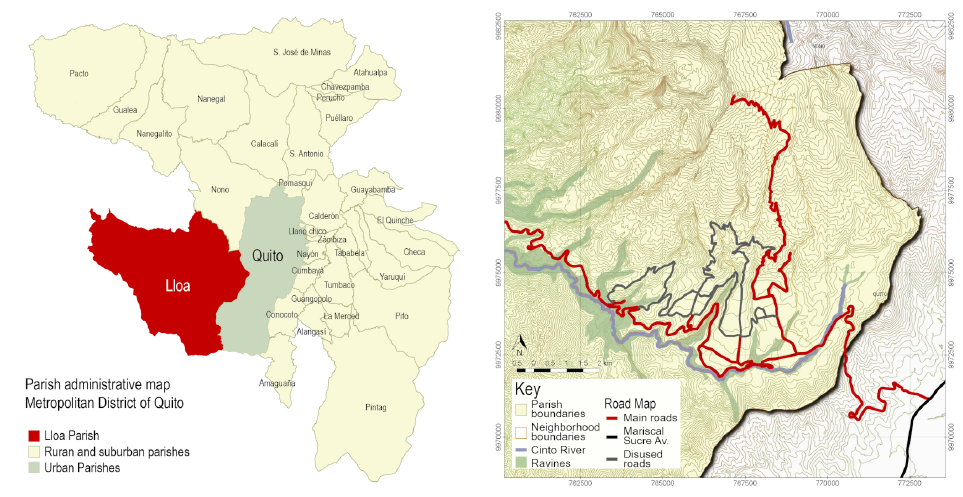
Figure 1: Lloa in the Quito Metropolitan District. Source: Lloa Development Plan and Land Use Planning (GADP de Lloa 2019); main and abandoned roads The lack of public transportation in human settlements like farms, villages, and other productive and tourist destinations forces people to organize their transportation through an ad hoc network without the benefit of any formal agreements. There are only three carriageways that pass through the parish. The Virgen del Cinto monastery, a recog- nized religious landmark, is located along the two routes that connect Chillogallo and Magdalena, two neighborhoods in Quito’s south. The connection with Chillogallo is con- sidered a first-order street, while the connection with Magdalena is a second-order